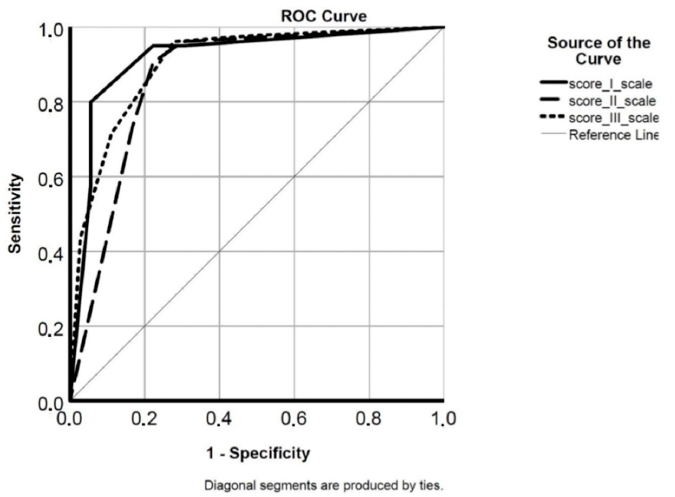
Scheme 2. Overview of the study population, including the results of all three observers.